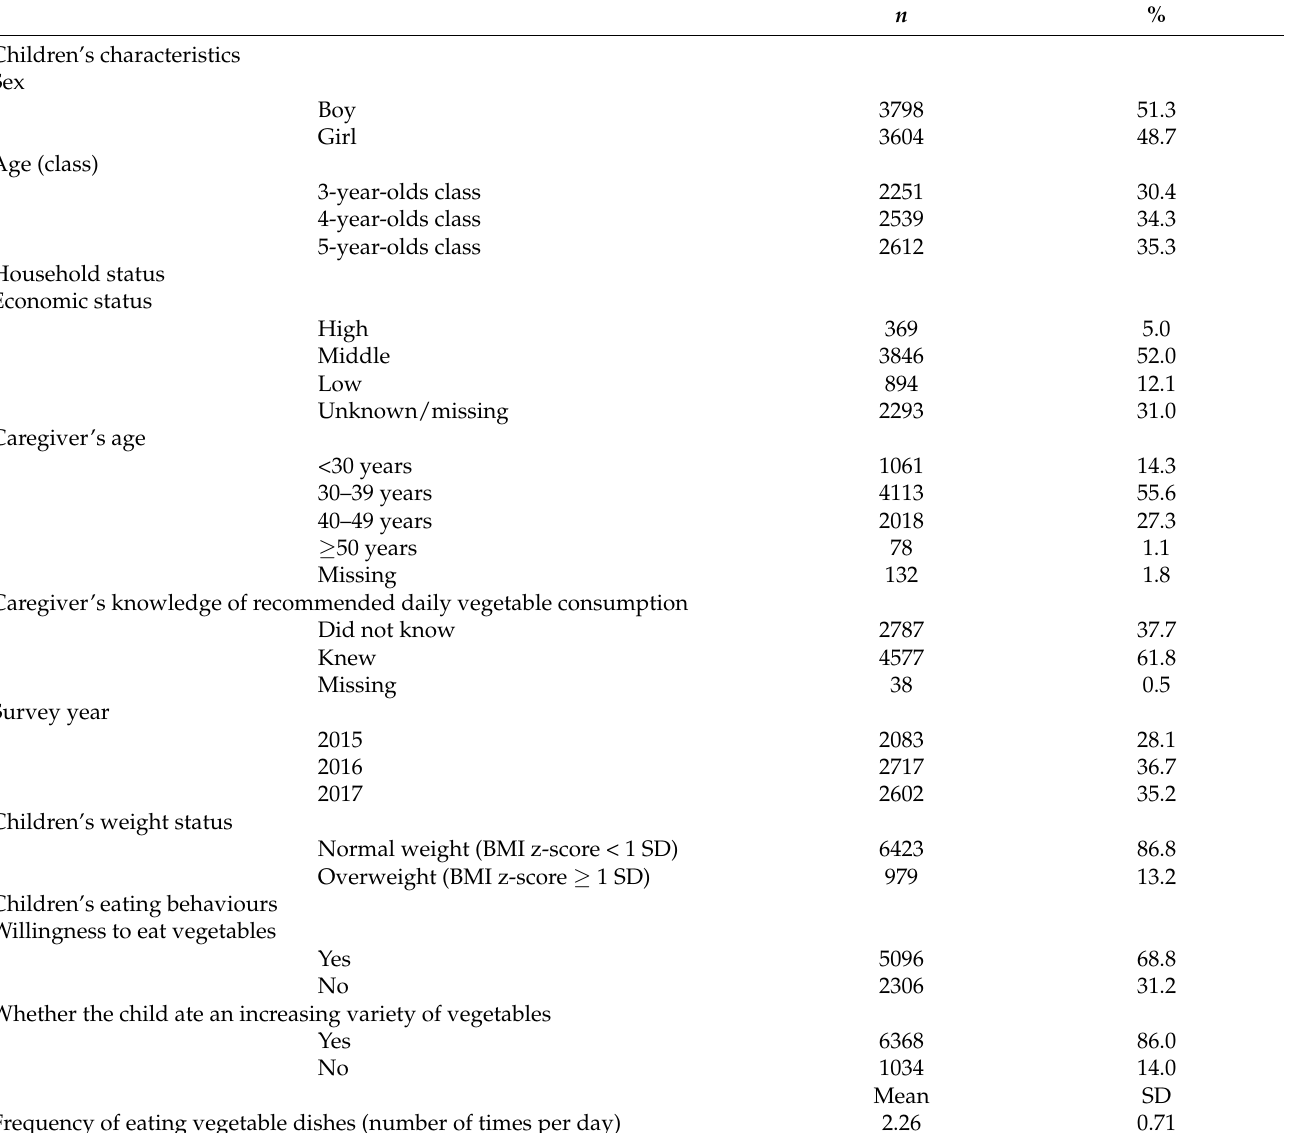
Table 1. Characteristics of enrolled preschool children and caregivers (n =